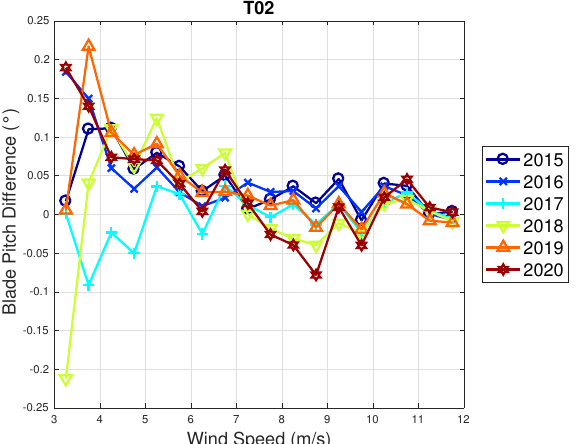
Figure 14. Binned wind speed–blade pitch curve for T02 in WF2: the curves are reported in the form of difference with respect to the year 2014.